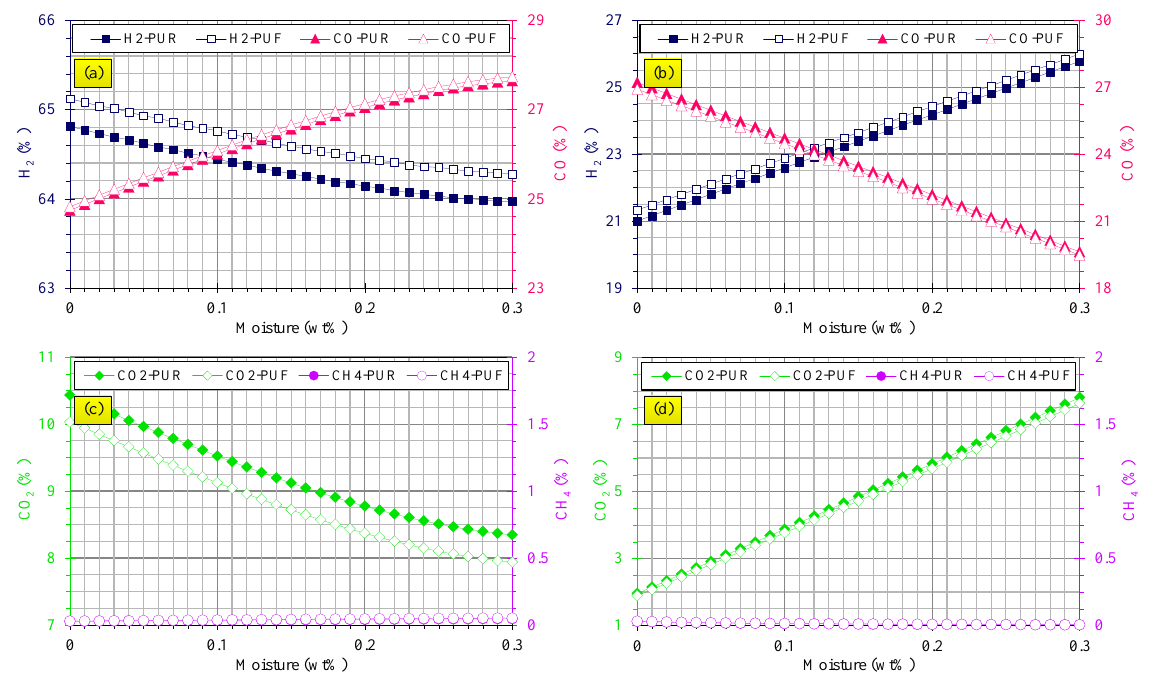
Figure 4. Effects of moisture content of waste flexible and rigid PU foams on ( a ) H 2 and CO yields in steam gasification, ( b ) H 2 and CO yields in air gasification, ( c ) CO 2 and CH 4 yields in steam gasification and ( d ) CO 2 and CH 4 yields in air gasification.